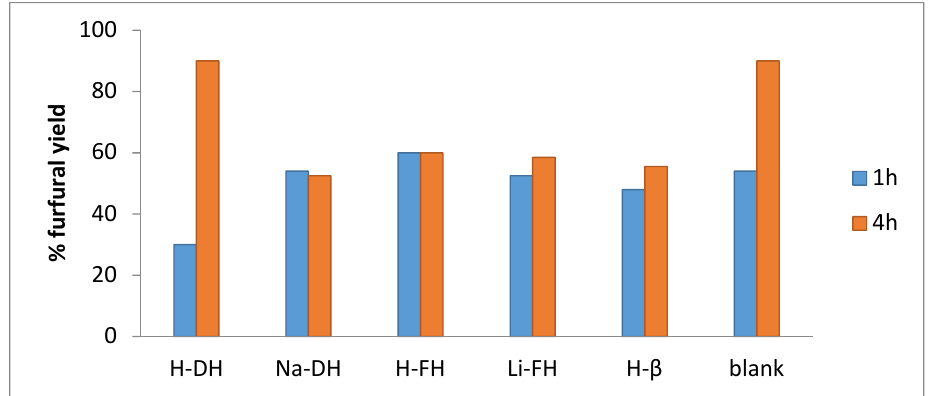
Figure 8. Furfural yields (%) using acid xylose extract solutions obtained from biomass and toluene as co-solvent in a ratio of 1:1 at 160 °C for 1 and 4 h for all catalysts. After 1 h of reaction, the best furfural yield was obtained with the H-FH catalyst (20%). The order was H-FH > H-DH > Li-FH > H- β > blank > Na-DH. This catalytic behavior can be